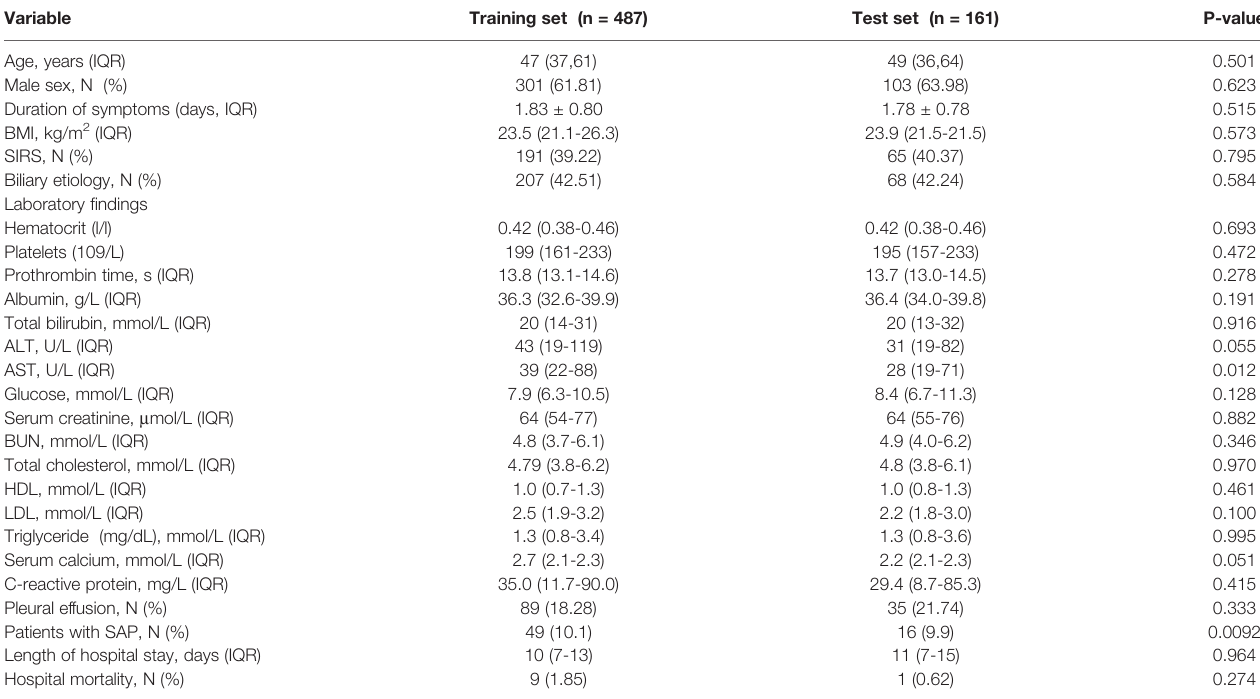
TABLE 1 | Comparison of clinical and laboratory fi ndings among patients, with and without SAP (training sample set).